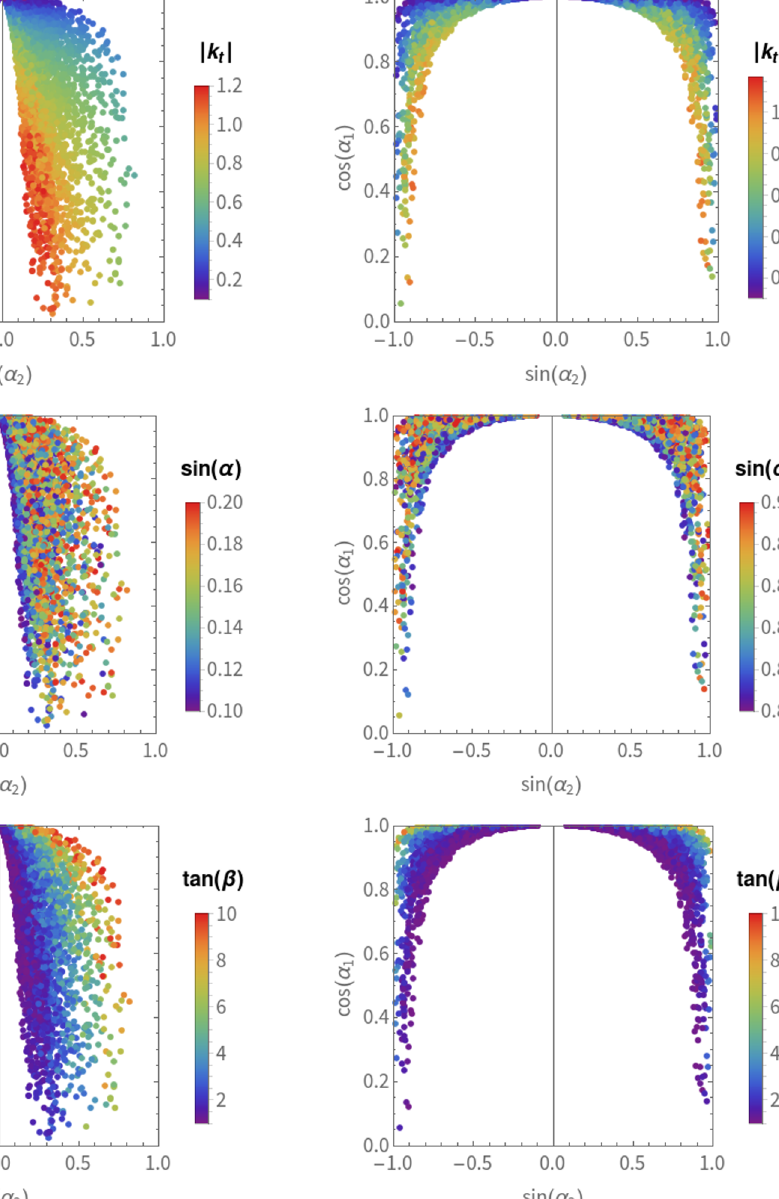
Figure 16. Points allowed in the plane c 1 vs. s 2 for 0 : 1 (cid:20) (cid:20) t (cid:20) 1 : 2 and 1 (cid:20) tan (cid:12) (cid:20) 10. In the left we impose 0 : 1 (cid:20) sin (cid:11) (cid:20) 0 : 2 (CP-even like) and in the right we impose 0 : 8 (cid:20) sin (cid:11) (cid:20) 0 : 9 (CP-odd like). On the top, we color superimpose (cid:20) t , in the middle sin (cid:11) and on the bottom tan (cid:12) .